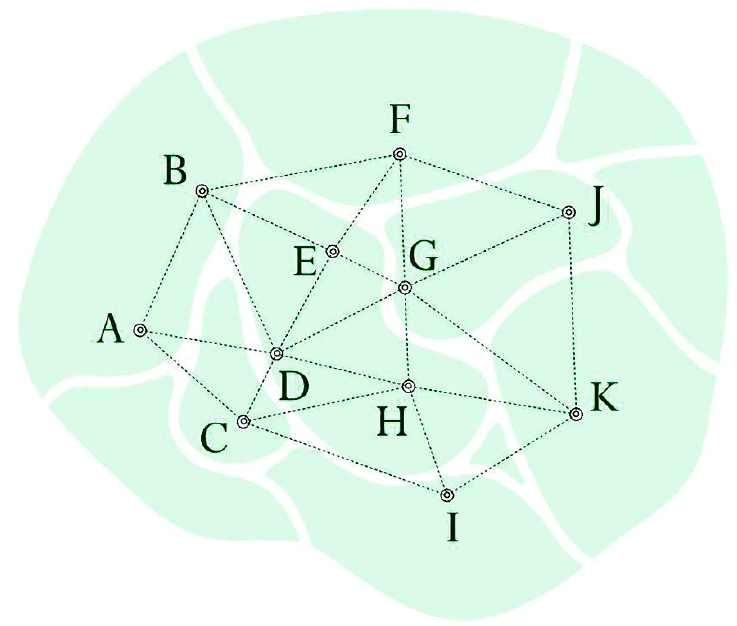
Figure 3. Delaunay Triangulation. Own source.